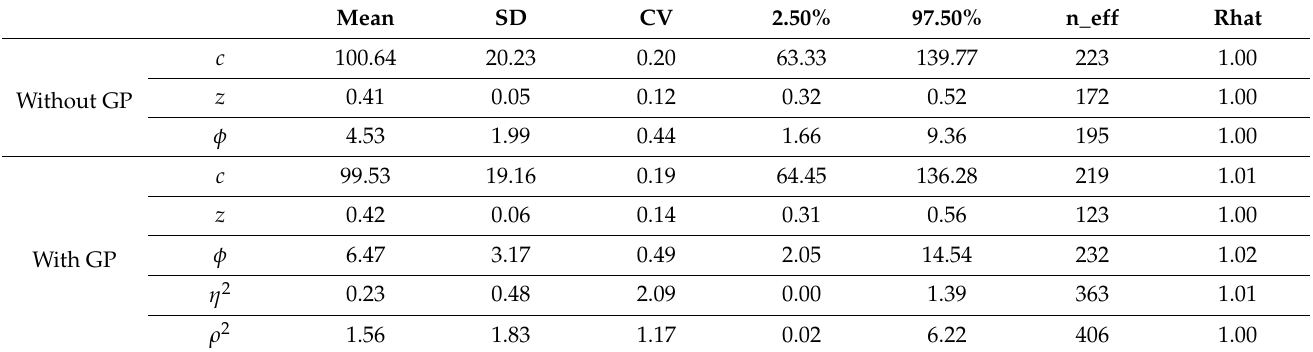
Table 1. Stan output for the ISAR model with and without the Gaussian process (GP) for the Azores. “SD” stands for standard deviation, “CV” for coefficient of variation, “2.50%” and “97.50%” correspond to the width of the credible interval, “n_eff” is the effective sample size, and “Rhat” stands for ˆ R (see main text).